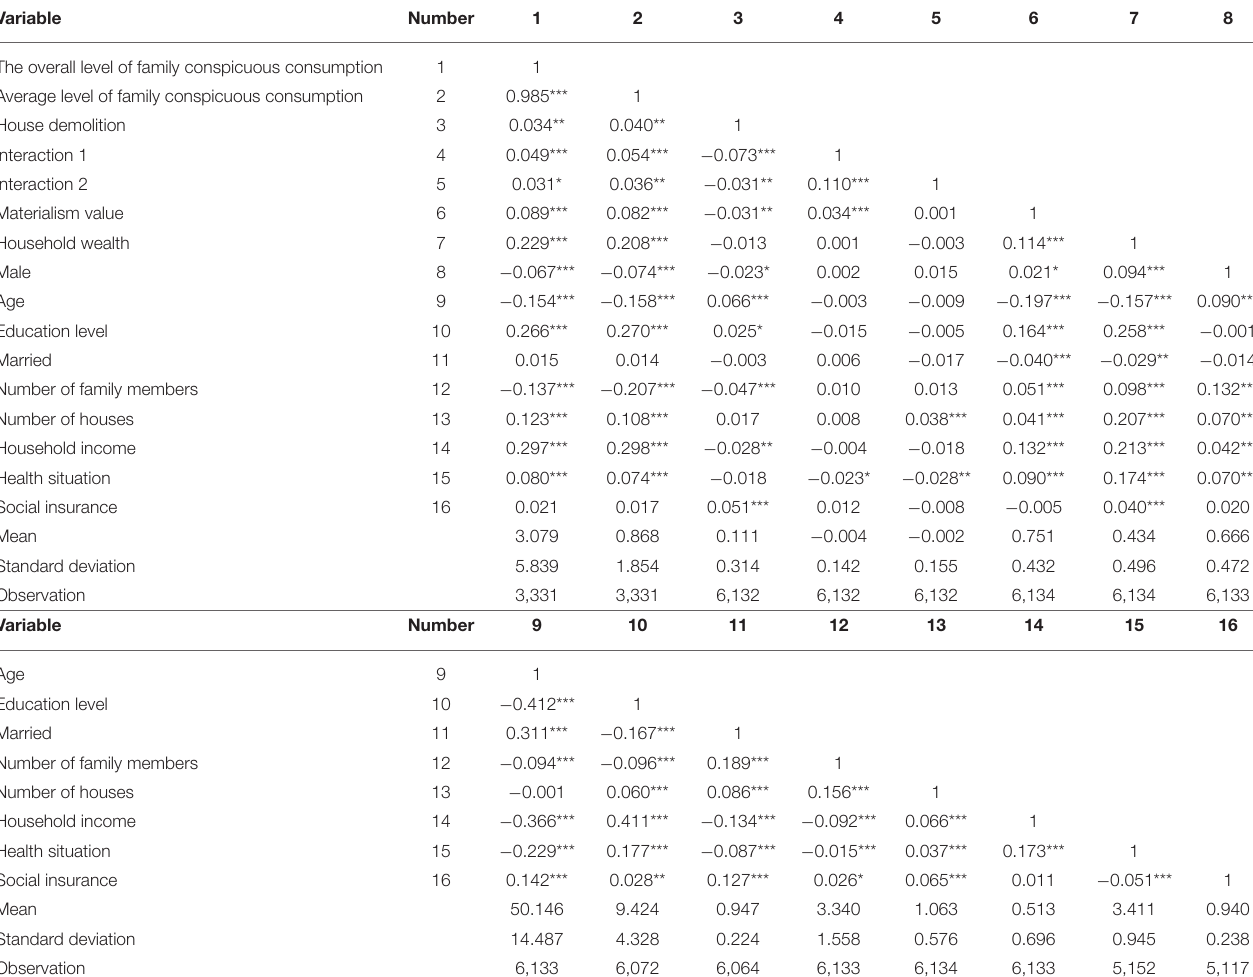
TABLE 1 | Descriptive statistics and correlation